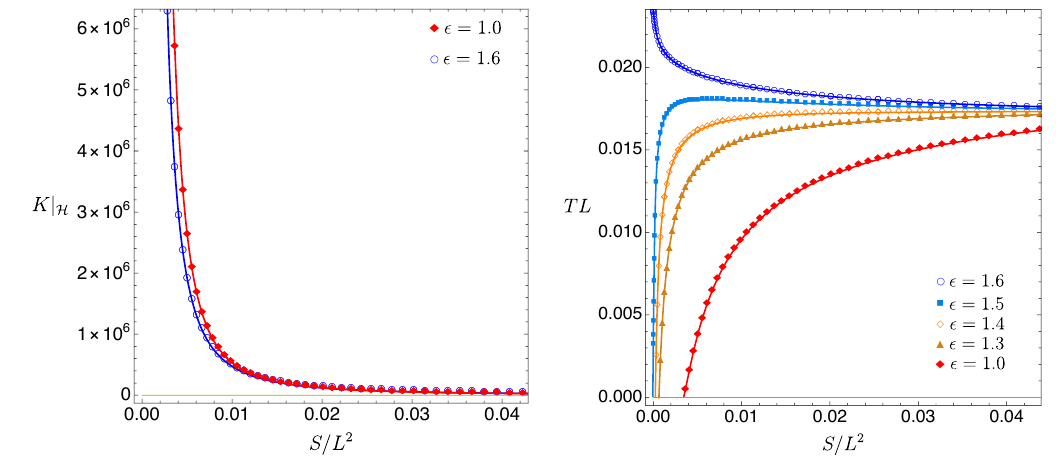
Figure 5 . Kretschmann curvature at the horizon (left panel) and temperature (right panel) as a function of the entropy ( S/L 2 = πR 2 ) for several hairy BH families with constant scalar amplitude + (cid:15) and scalar field charge e = 1 . 85 ( e γ ≤ e < e c